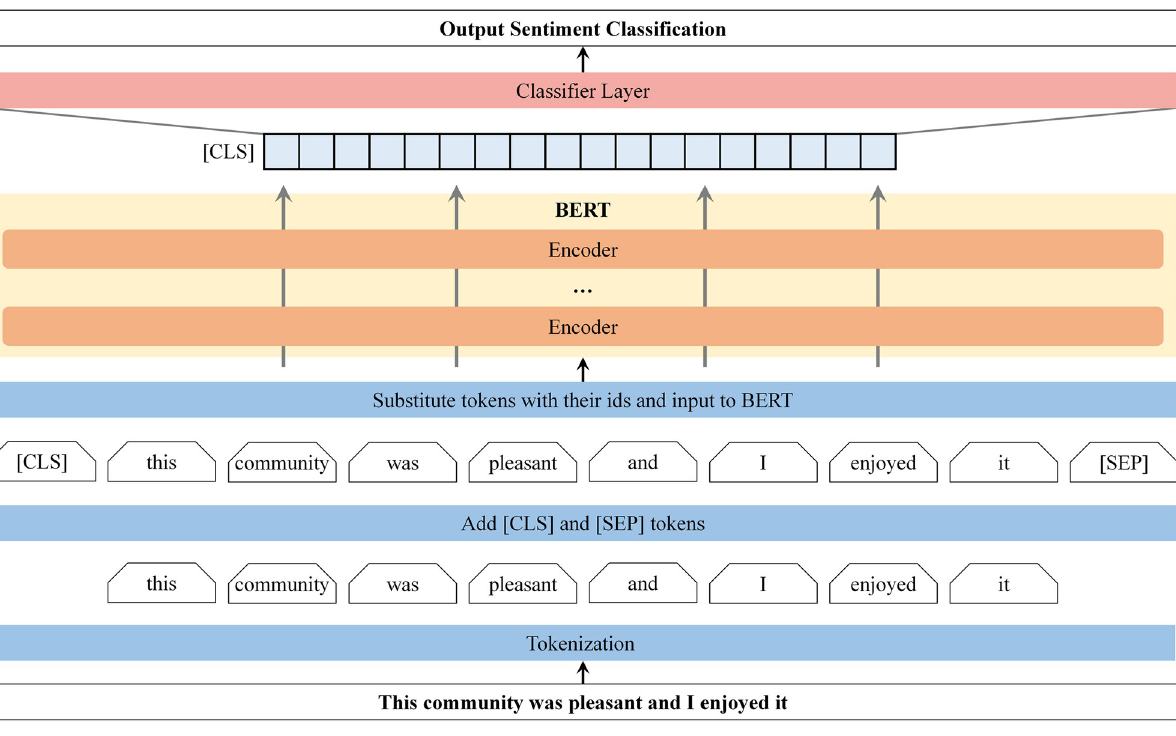
Fig 1. Overview architecture of BERT model. Adapted from Devlin et al.